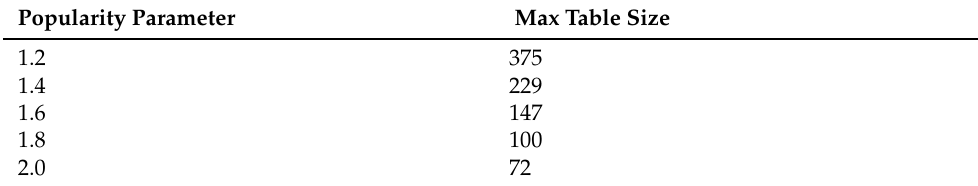
Table 3. Maximum popularity table size as a function of different popularity parameter values. Popularity